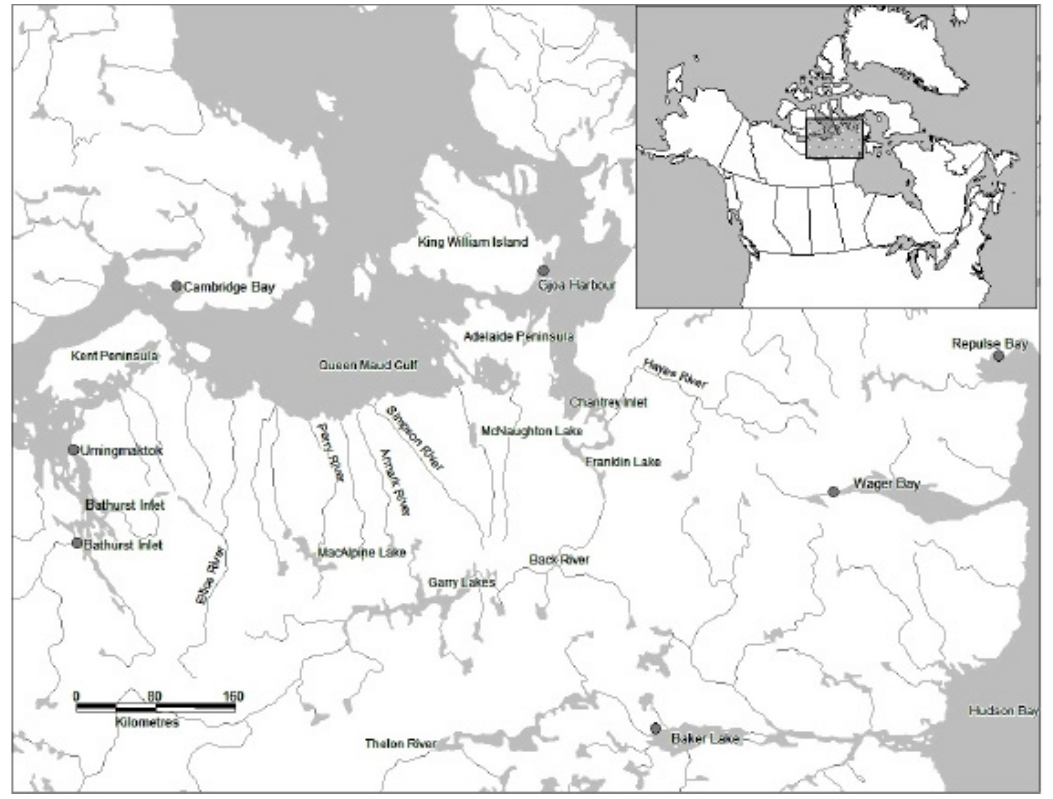
Fig. 1. Queen Maud Gulf and surrounding area, north central mainland,